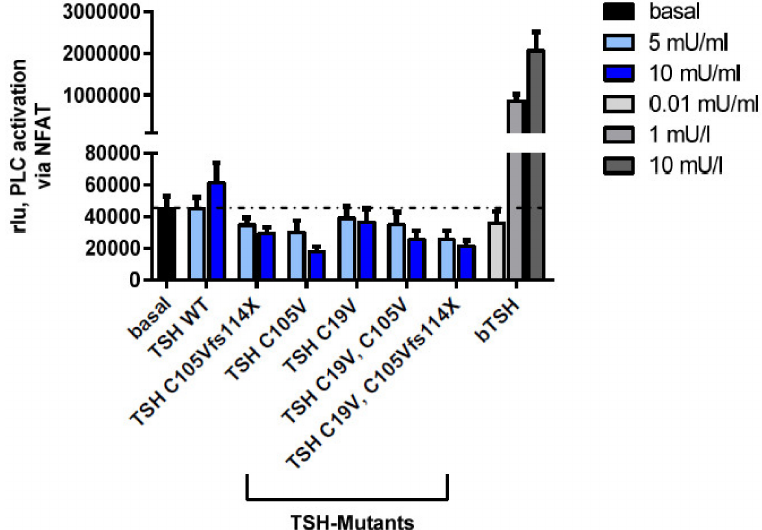
Figure 7. Determination of Gq / G11 Phospholipase C- β activation of WT-TSH and TSH mutants in HEK293 cells. Functional characterization (Gq pathway) via a reporter-gene assay with NFAT of the WT-TSH and tested mutants. Data are expressed as mean ± SEM of four independent experiments performed in triplicate. For statistical analysis, one-way ANOVA with the Kruskal-Wallis test for basal activity of the TSHR against the WT, all mutants at all